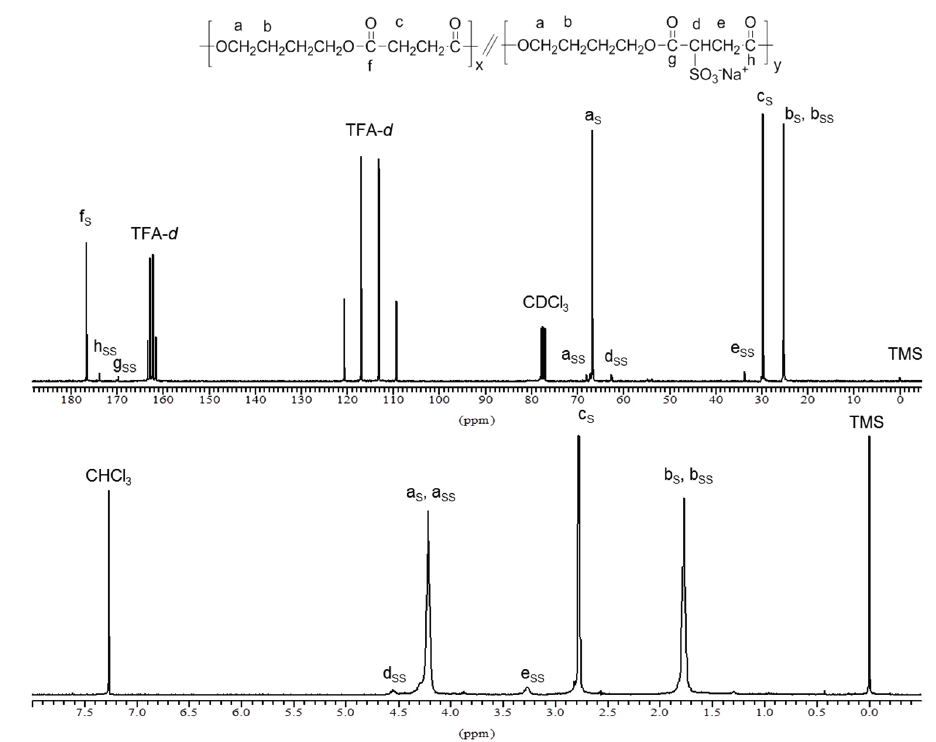
Figure 1. 1 H NMR ( bottom ) and 13 C NMR ( top ) of PBS 85 SS 15